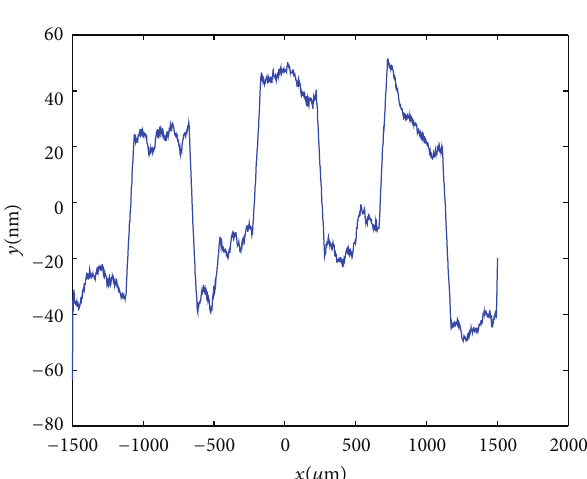
Figure 10: Flow chart for taking a profile measurement.